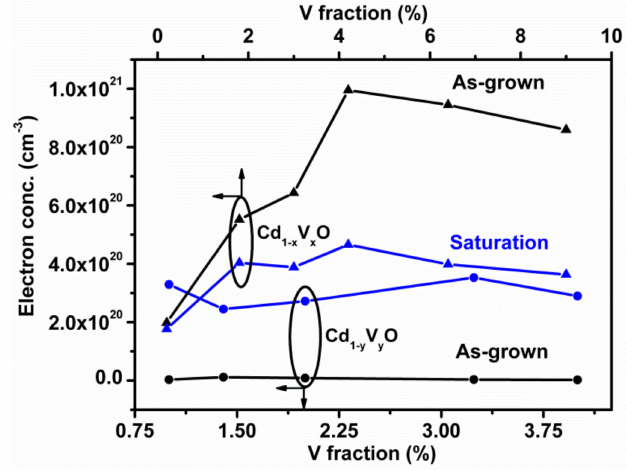
Figure 3. Saturated electron concentrations in Cd 1 − x V x O (x = 0.2~9%) and Cd 1 − y V y O (y = 1~4%) series; as-grown are also